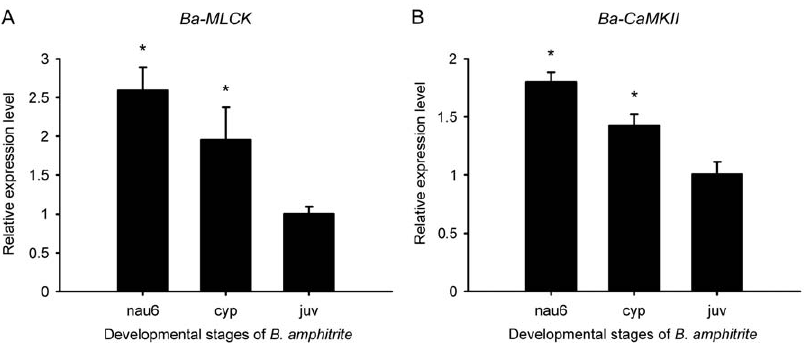
Figure 7. Ba-MLCKandBa-CaMKII mRNA expression levels in different developmental stages of B.amphitrite . Relative gene expression levels of MLCK (A) and CaMKII (B) were detected by using real-time PCR in stage VI nauplius (nau6), cyprid (cyp) and juvenile (juv). Bars represent the mean 6 SD (n=3). Asterisks (*) indicate significant differences compared with the positive control ( P , 0.05).